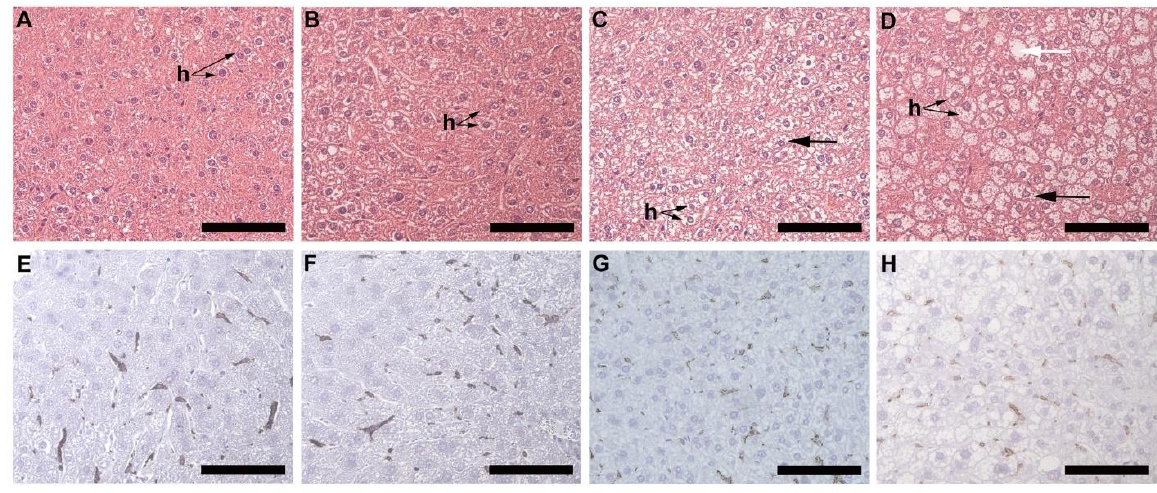
Figure 4. Histology and immunohistochemistry of BAT. Histological sections showing adipocytes in BAT of CD females, ( A ); CD males, ( B ); HFD females, ( C ); and HFD males, ( D ). Adipocyte expansion was evident in the HFD males, ( D ) and females, ( C ) compared to the CD males, ( B ) and females, ( A ). F4/80+ immunostained sections from CD females, ( E ); CD males, ( F ); HFD females, ( G ); and HFD males, ( H ). Macrophage infiltration (black arrow) was only evident in males on CD, ( F ) and HFD, ( H ) with the HFD males displaying a significantly greater extent of macrophage infiltration, ( I ). No macrophages were observed in the females on either CD, ( E ) or HFD, ( G ). ¥ Significant difference between CD male and HFD male p < 0.05. Mean ± SD. Scale bar: 100 µm.